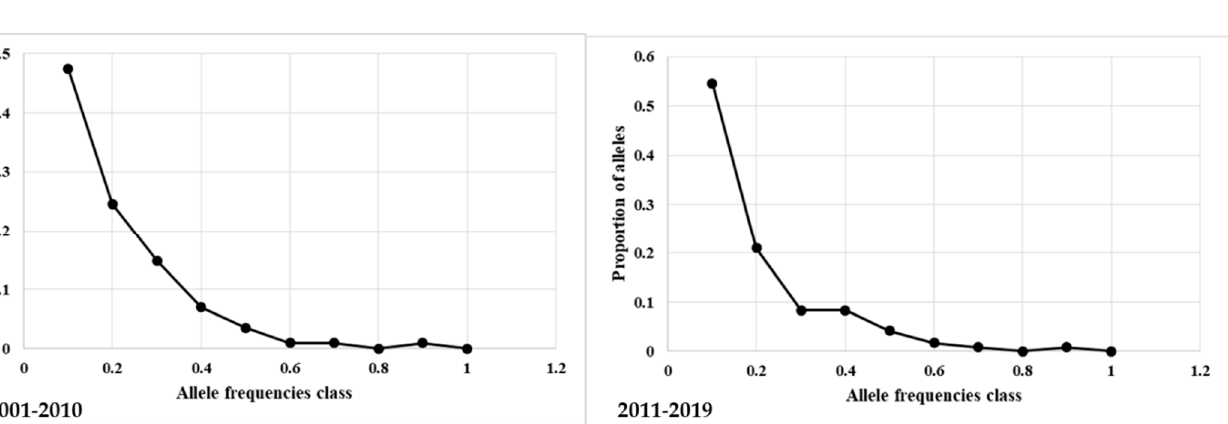
Table 2. Mean F is , values in the total population (related and unrelated) and the unrelated horses in different periods.